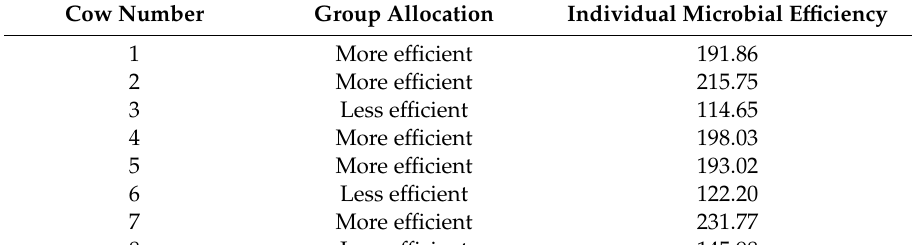
Table A2. Group allocation based on the individual microbial e ffi ciency.